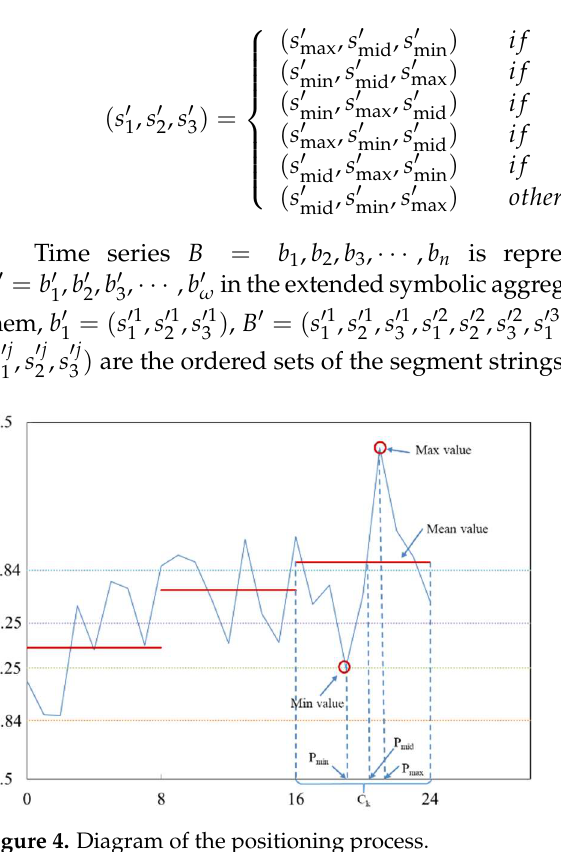
Figure 4. Diagram of the positioning process.